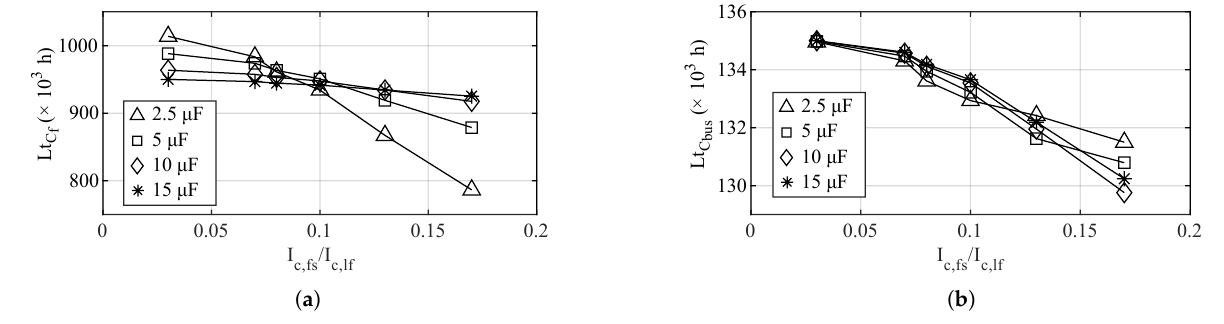
Figure 11. Estimated capacitor lifetimes as a function of I c , f . . ( b ) Lt C / I c , lf . ( a ) Lt C s bus f The oscilloscope and power meter measurements are shown in Figure 12. The oscillo- scope waveforms in channel 1 show the drain-to-source voltage over the MOSFET; channel 2 the AC-side voltage; channel 3 the current in L c ; and channel 4 the current in L g . The total losses measurement is: P loss = 1001.7 − 960.6 = 41.1 W, corresponding to the reading of el- ements P 1 − P 5. Measurements were taken at other points of the circuit: P 1 − P 2 = 22.1 W represents the losses of the converter (MOSFET and DC Bus combined); P 2 − P 3 = 12.6 W represent P L ; P 3 − P 4 = 3.3 W represent P C and P R combined; P 4 − P 5 = 3.1 W represent c f f P L . Estimated losses were: 3.66 W for P L ; 13.38 W for P L ; 0.10 W for P C ; 2.19 W for P R ; g g c f f 16.49 W for P MOS ; and 3.50 W for P C , adding up to 39.32 W. The difference between the bus measured and estimated value is of 1.78 W, corresponding to 4.33% of the measured value.